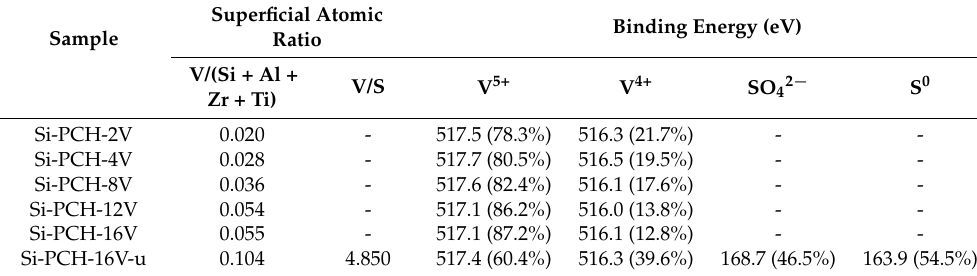
Table 3. Superficial atomic ratios and V 2 p 3/2 and S 2 p 3/2 binding energies for the V-based catalysts.